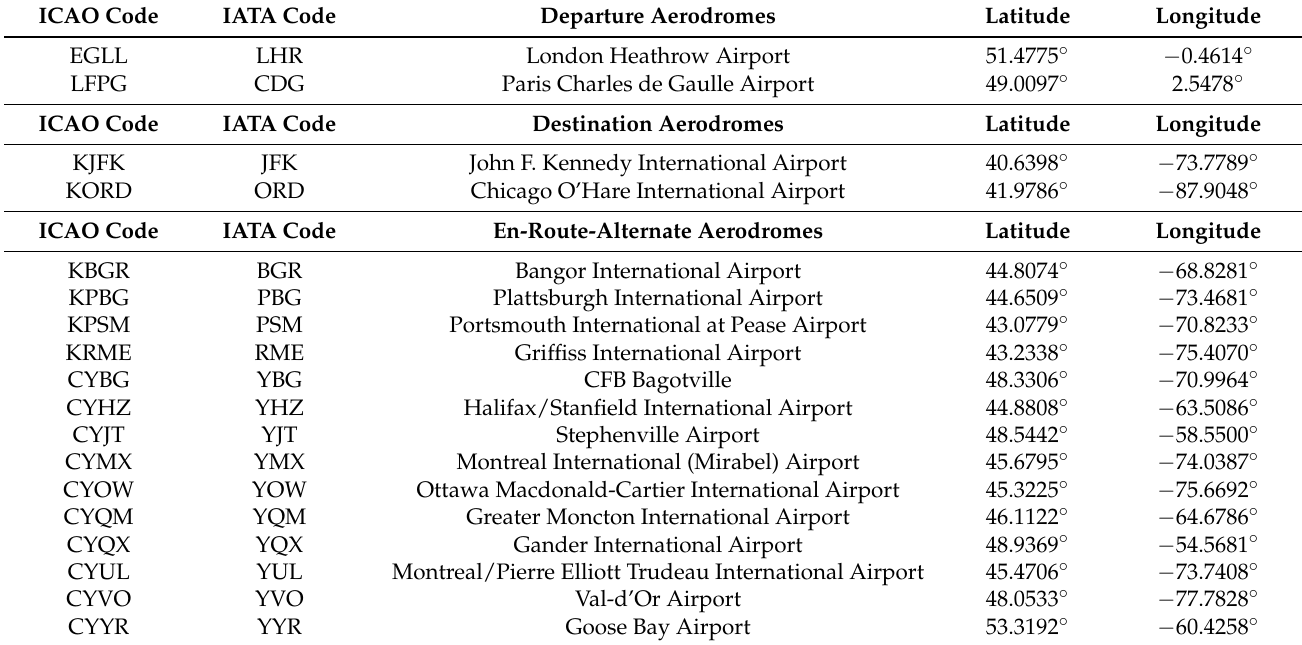
Table A2. Aerodromes under